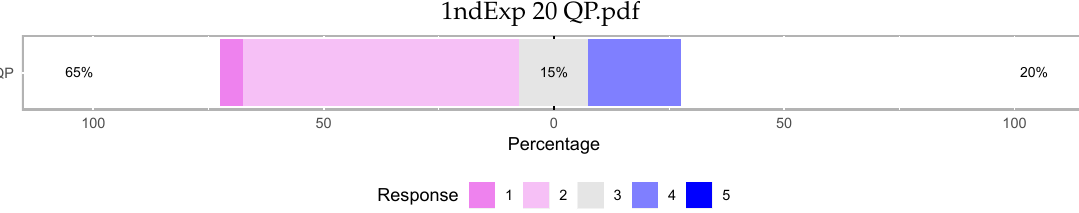
Figure 10. A graphical representation of the distribution of the answers to QB, QE and QU in Experiment 1.